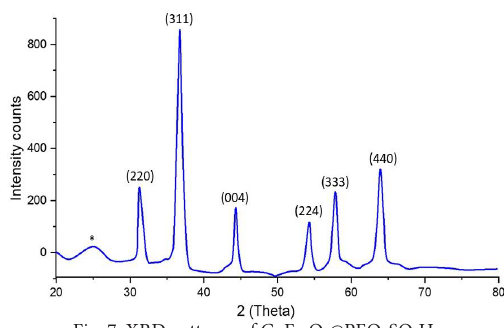
Fig. 7. XRD patterns of CuFe